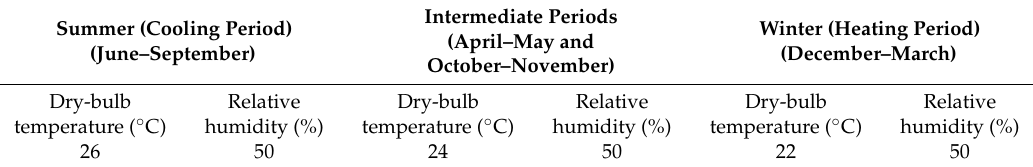
Table 4. Air-conditioning setting in an office.